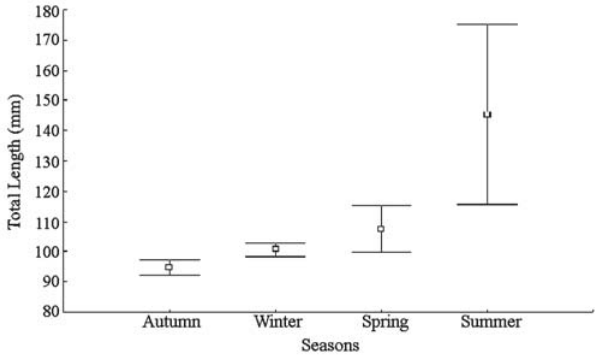
Fig. 5. Average length of Isopisthus parvipinnis and confi- dence interval of 95% (n = 990) across seasons of those indi- viduals captured along the coast of Ilhéus, Bahia,